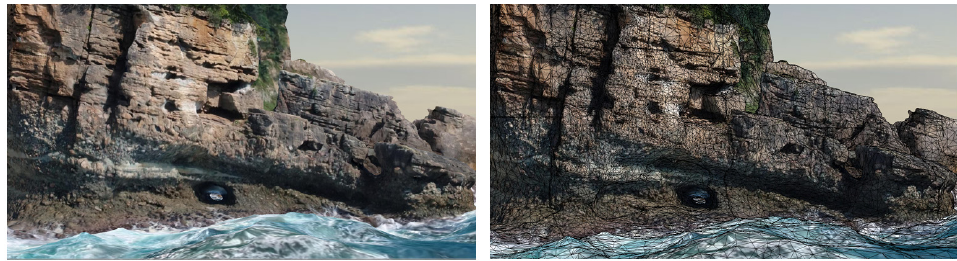
Figure 8. Textured triangle and wireframe overlay models.